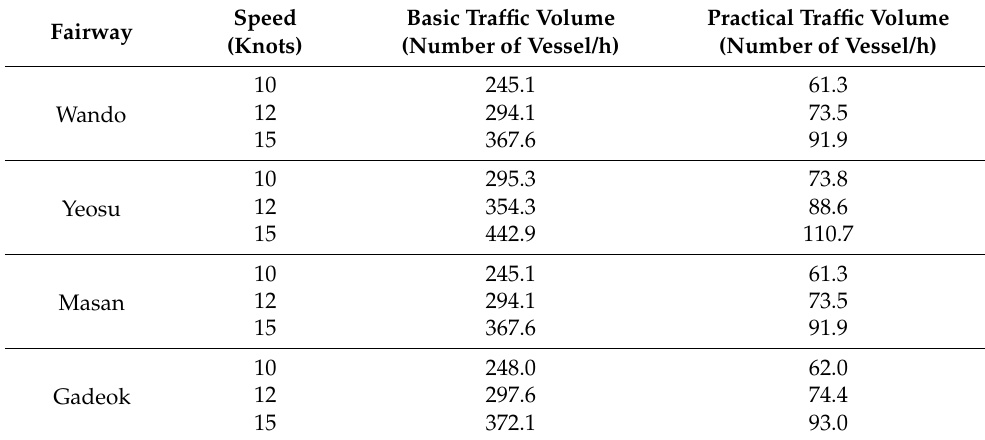
Table 5. Basic traffic capacity and practical traffic capacity by destination